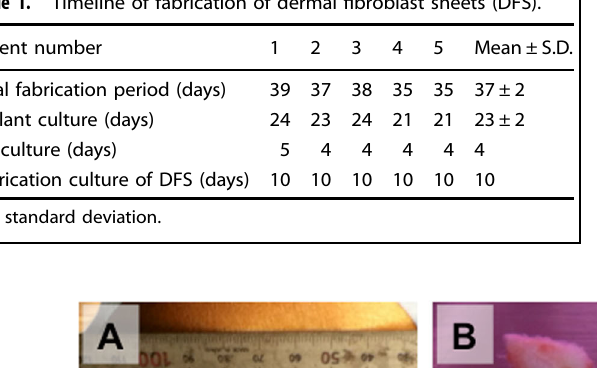
Table 1. Timeline of fabrication of dermal fi broblast sheets (DFS).